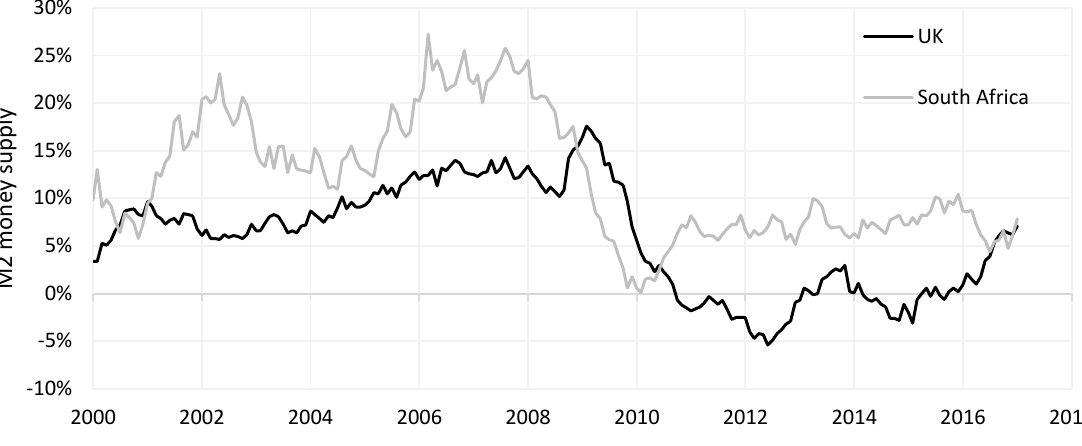
Figure 4. Comparison of South Arica’s and the UK’s M2 money supply rates from 2000 to